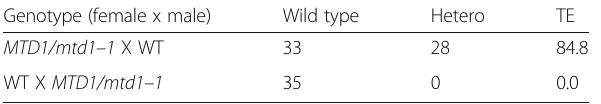
Table 2 Genetic transmission analysis of MTD1 / mtd1 by reciprocal crossing Genotype (female x